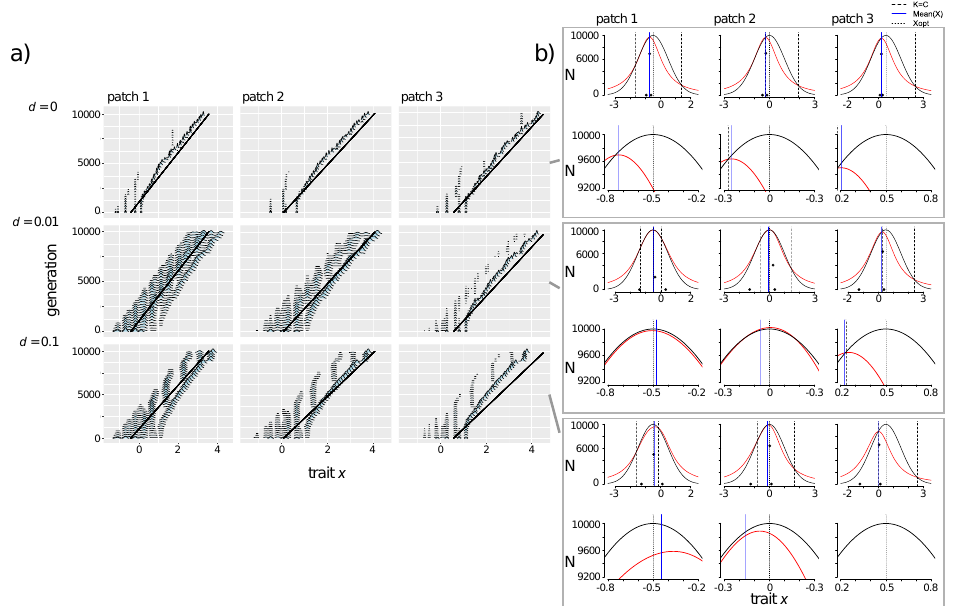
Figure 4. Trait evolution and competition for multispecies communities over time in a rapidly changing environment ( ∆ = 4 × 10 −4 , σ α = 0.68, d = 0, 0.01, and 0.1). ( a ) Distributions of phenotypes in populations and communities over 10,000 generations of the evolving metacommunity simulation (for evolution over 50,000 generations, see Figure 3, Figures S6 and S7, third row). At all levels of dispersal, all but a single species went extinct within ~6000 generations. When d > 0, competition with new mutant populations leads to periodic selection for divergent trait values but these are then lost to extinction as the environment continues to change. This intraspecific diversity is always highest in patch 1, where selection for increasing traits is driven by environmental change but immigration from the other patches creates increased selection pressure for lower competition strength and thus lower trait values. ( b ) Competition strength ( C ( x ), red line, Equation (3) and carrying capacity ( K ( x ), black line, Equation (1) as a function of trait values ( x axis), calculated as average values from 121 sampled generations spaced evenly from generation 20,000 to 50,000. Without dispersal, the changing environment selects for individuals with higher trait values in all patches. When patches are linked by dispersal, immigrants are introduced and in patch 1, these increase the fitness of individuals with lower trait values that experience less competition than individuals with higher trait values. These mutant populations arise periodically then become extinct as the environment continues to change. Features of all plots are as described in Figure